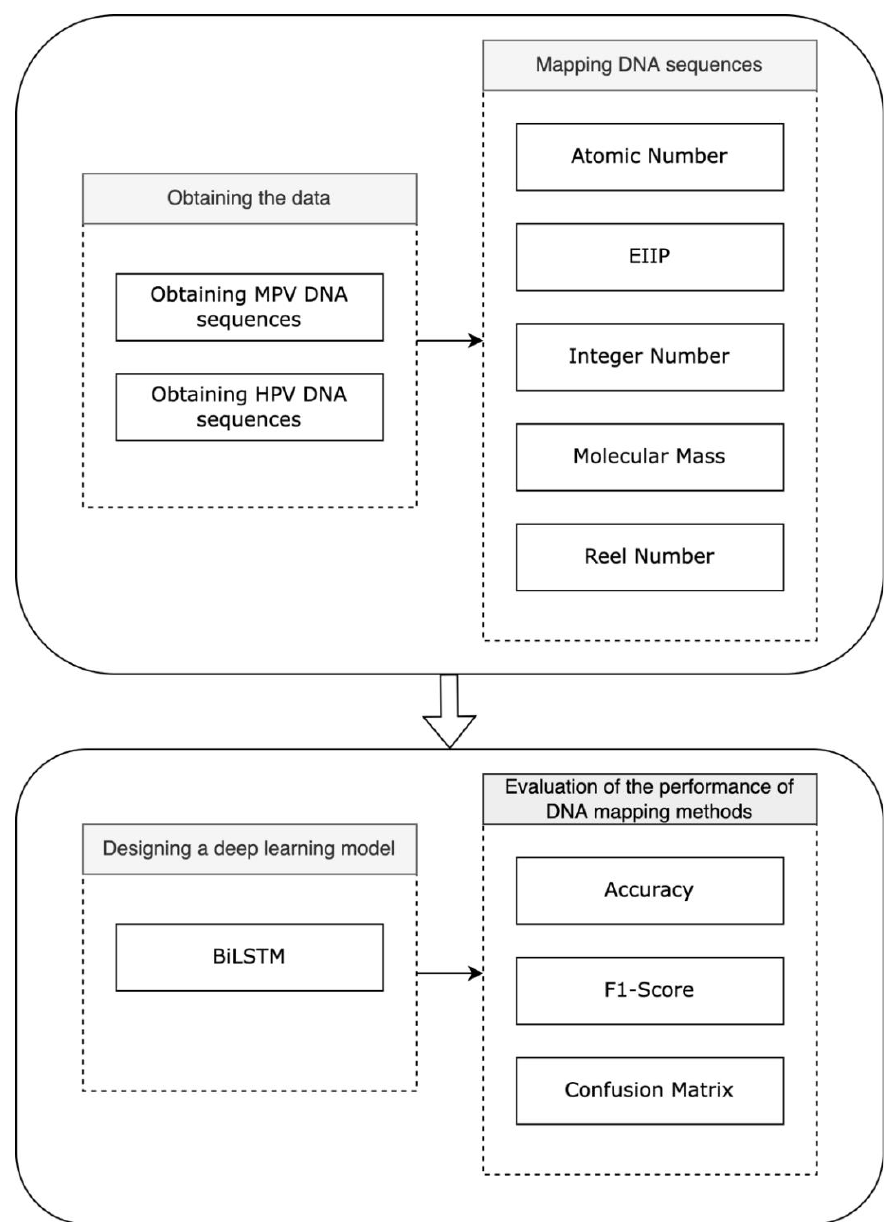
Figure 1. Flowchart of the study.